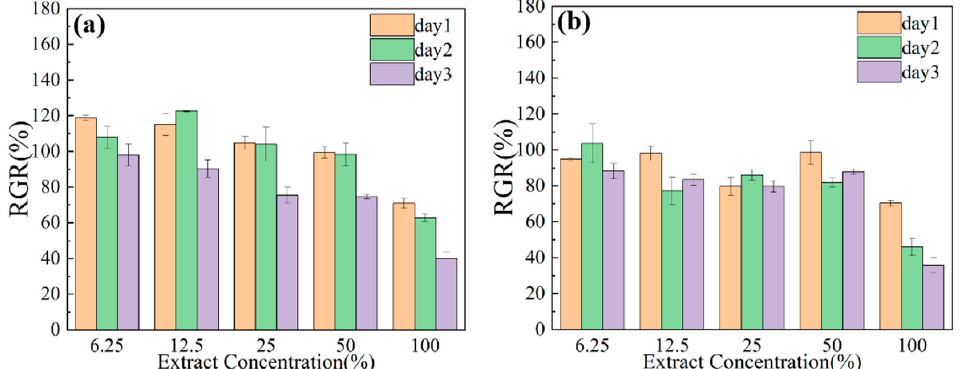
Figure 6. Survival of ( a , b ) MC3T3-E1 cells cultured in the Zn-1Cu-xAg alloys at different concentra- tions of leachate for 1, 2 and 3 days. Figure 7 displayed the fluorescence images of MC3T3-E1 cells adhering to the surface of Zn-1Cu-xAg (x = 0.5, 1) alloy after co-culture for 24 h. This fluorescence image can vis- ualize the adhesion ability and cytocompatibility of the Zn-1Cu-xAg alloys’ surface to the cells. In spite of the different Ag contents, only a small number of cells adhere to the Zn-